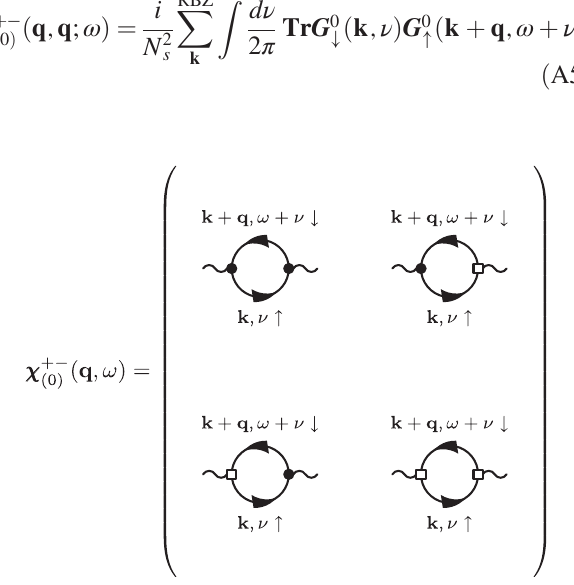
26. Diagrammatic representation of the MFT transverse spin susceptibility matrix; see Eq. (37). The sums over internal momentum k and frequency ν have not been written